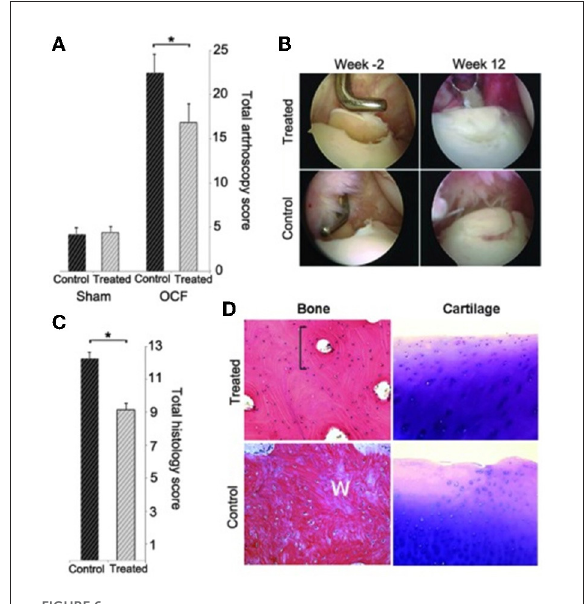
FIGURE6 Changes in tissue pathology associated with scAAV.eqIL-1Ra treatment in an equine model of OA (A) showing a significant decrease in total arthroscopy scores for treated joints compared to the control joints (B) Representative arthroscopic images of the osteochondral lesions in treated and control horses at the time of OA induction (week -2) and at the endpoint (week 12) (C) showing a significant decrease in total histologic scores for treated joints compared to controls consistent with the microscopic appearance of bone repair tissue (H&E) and cartilage (toluidine blue) in treated and control joints (D) Reproduced with permission from R. S. Watson Levings et. al, 2018 (91). An asterisk (*) linking treatment groups indicate a statistical difference ( p < 0.05) between treatment